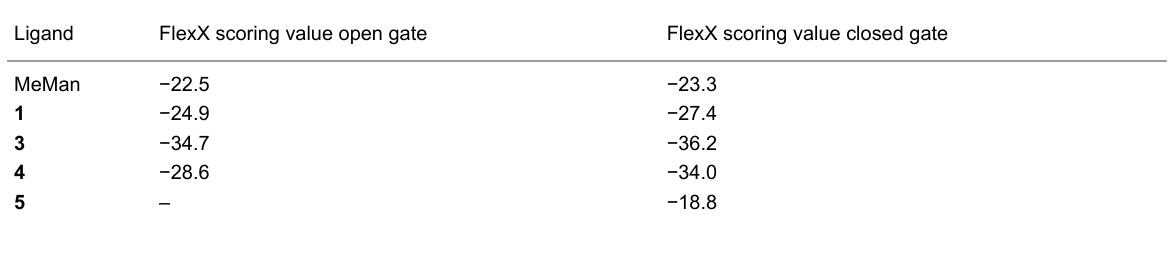
Table 1: FlexX scoring values for photolabile mannosides 3 – 5 in comparison with methyl α -D-mannopyranoside (MeMan) and p NPMan 1 for the open and closed gate crystal structure of FimH (PDB 1KLF and 1UWF,